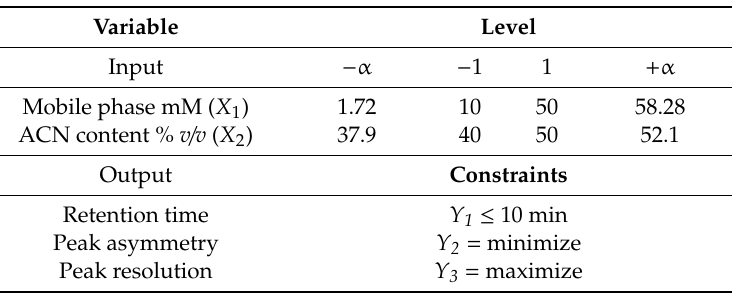
Table 1. Variables and experimental design values.